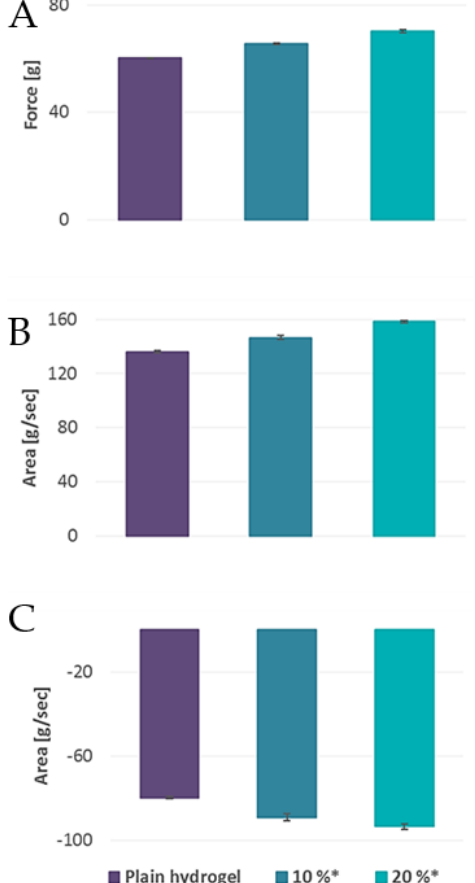
Figure 4. Texture analysis determining the hydrogel hardness ( A ), cohesiveness ( B ), and adhesiveness ( C ) for chitosan hydrogels (2.5% w / w ) with and without liposomes ( n = 3). * Concentration of liposomal suspension incorporated into hydrogel (%, w / w ). Table 2. Detachment force and formulation retained on the tissue for chitosan hydrogels (2.5 and 3%, w / w ).